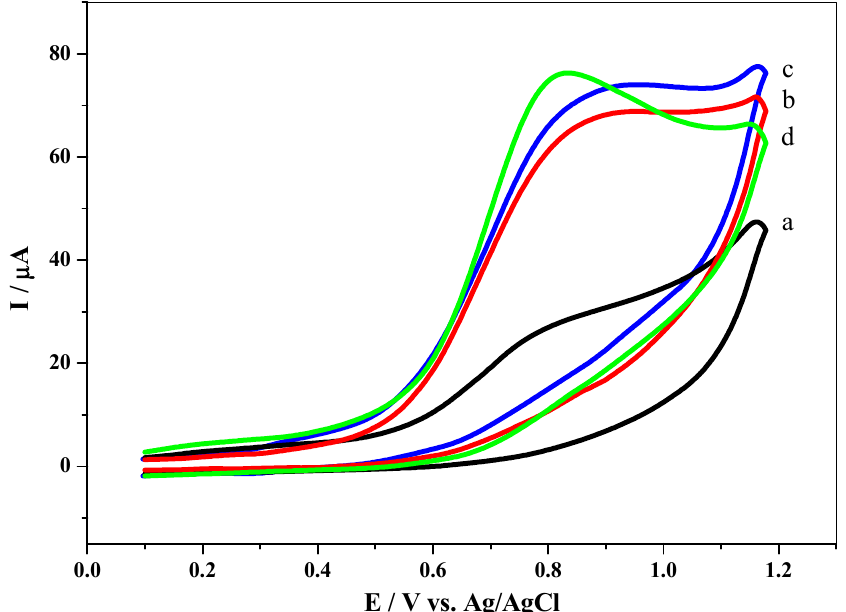
Figure 7. CVs of 3.5 mM of NIC in 0.10 M Na 2 SO 4 (pH 8.0) at (a) a bare GCE, (b) the Nq/GCE, and (d) the GO/GCE (c) the GO/Nq/GCE at a scan rate of 100 mV/s.